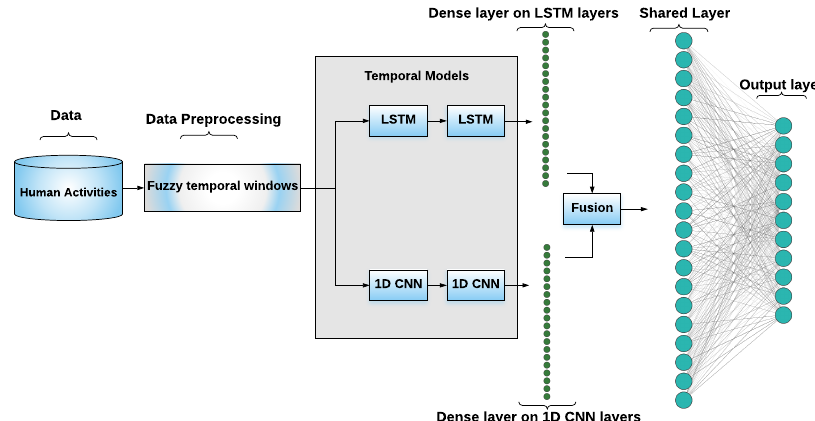
Figure 5. Architecture of the proposed joint learning of temporal model for human activity